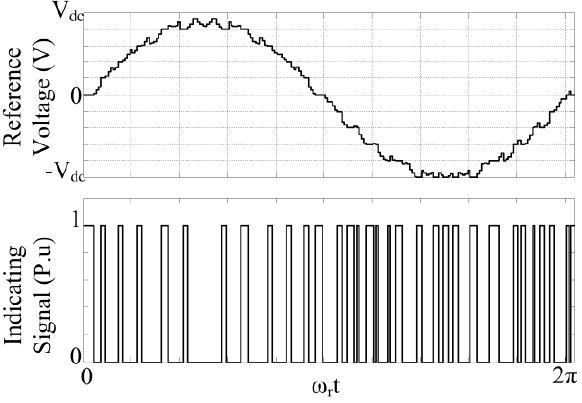
Figure 11. Reference and indicating signal under the discontinuous modulation.